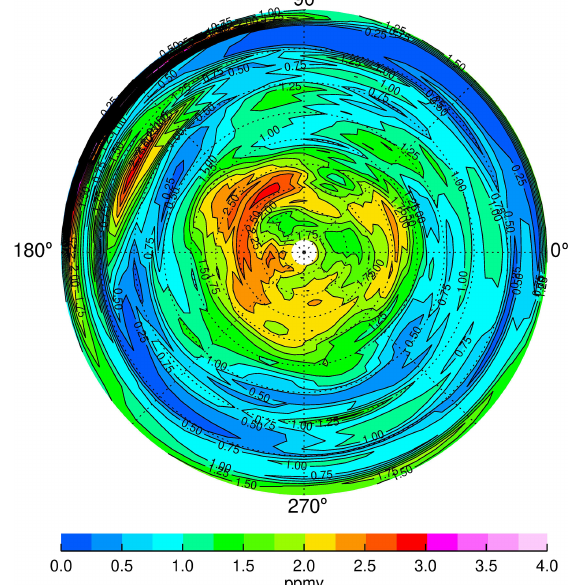
Figure 15. NH V6 combined (A+D) ozone distribution at 68hPa for 15 December 1978. CI is